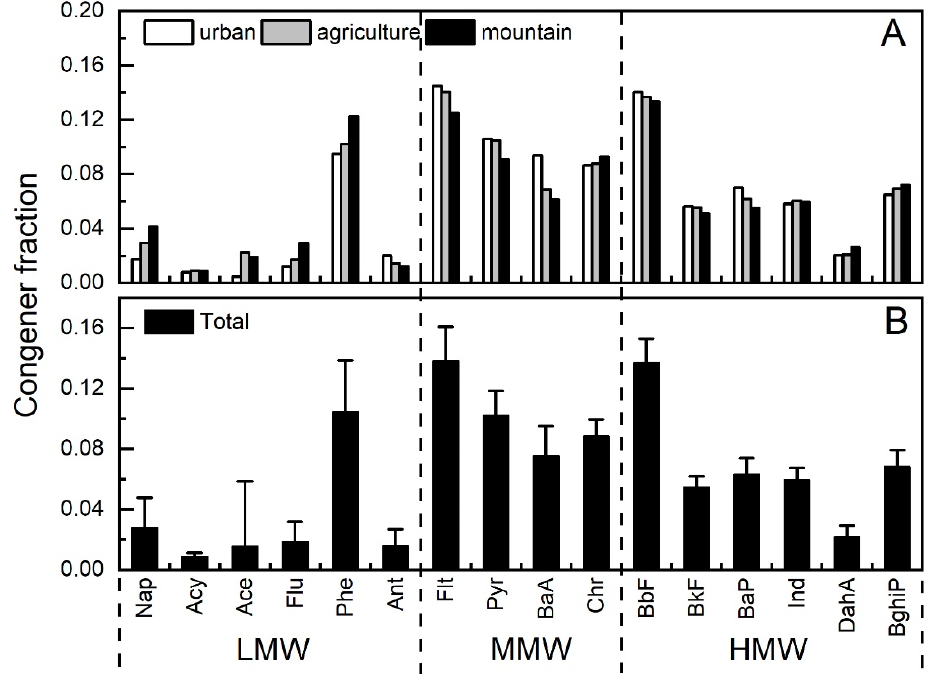
Figure 3. Profile of 16 U.S. EPA (Environmental Protection Agency) PAHs in the soil: ( A ) the mean profile for the urban area, agricultural, and montane soil and ( B ) the mean profile for all the soil samples. The error bars represent standard derivations (SD) across all samples. LMW: low molecular weight, MMW: medium molecular weight, HMW: high molecular weight.